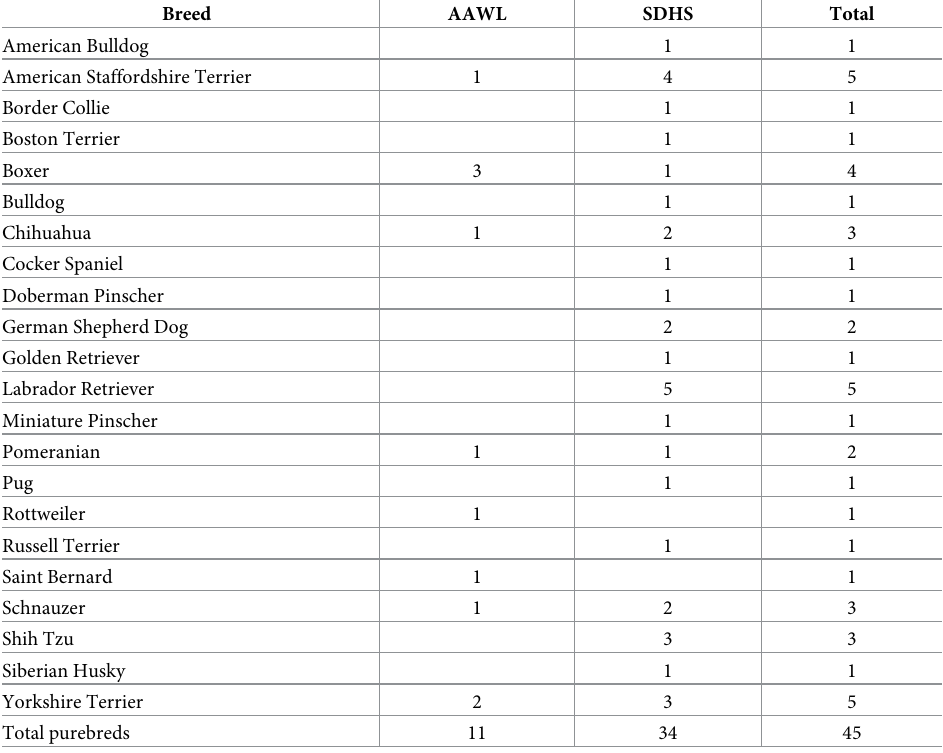
Table 1. Number and breeds of purebred dogs at Arizona Animal Welfare League and San Diego Humane Society. Breed AAWL SDHS